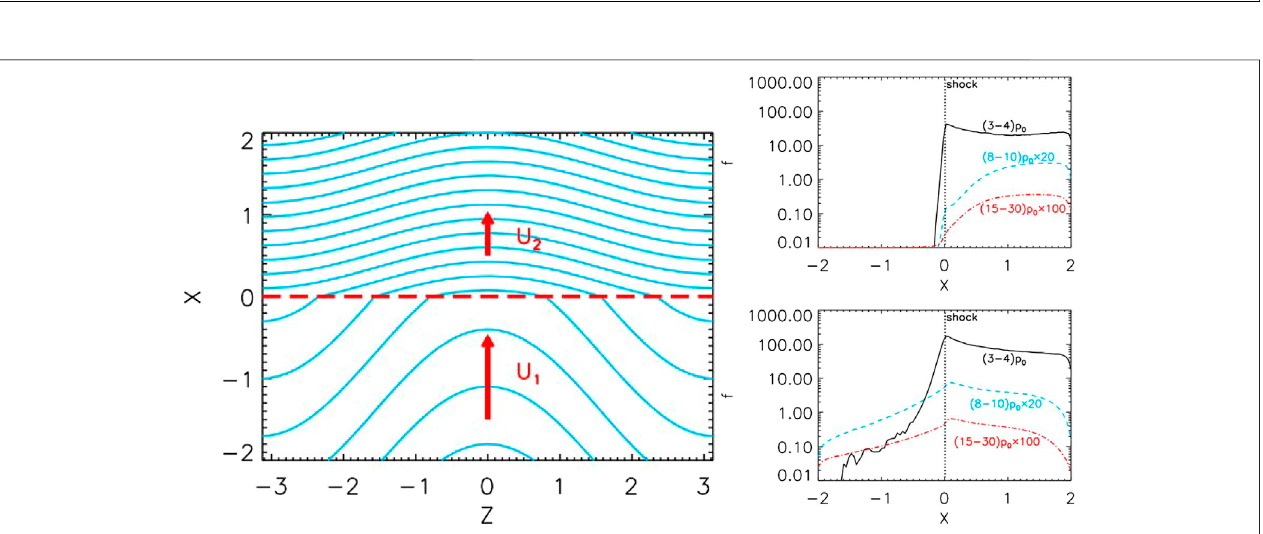
FIGURE3| Left:Shock(reddashedline)andmagnetic fi eld(bluelines)geometryforanupstreamaveragemagnetic fi eldperpendiculartotheshocknormal.U1and U2givetheupstreamanddownstream fl owvelocities,respectively.Right:Pro fi lesofdensityoftheacceleratedparticles,forlow(blacklines),medium(bluedashedlines), and high (red dot-dashed lines) energy ranges at different locations z (cid:1) 0.0 (top) and π (bottom) , respectively (Guo et al.,